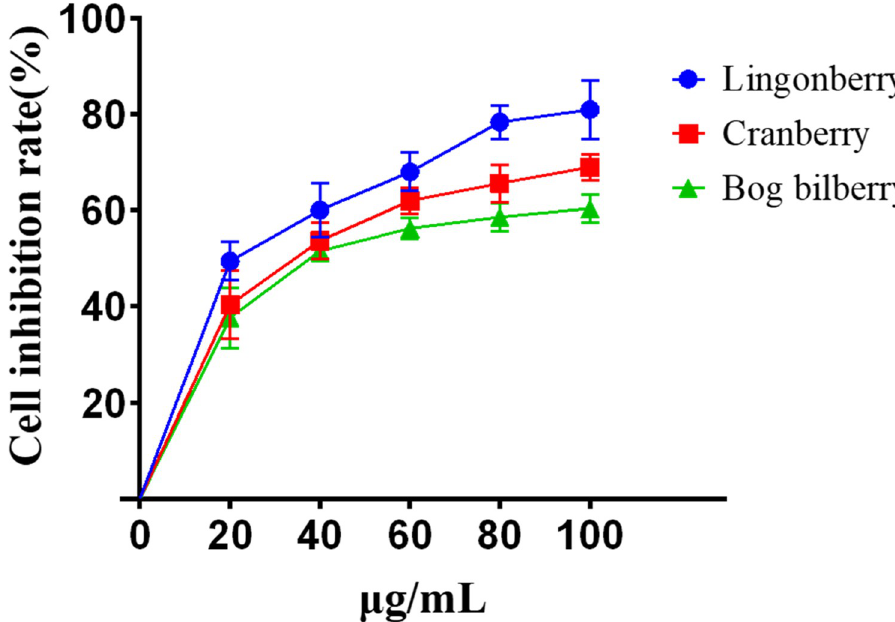
Fig 2. Inhibition rates of various Vaccinium berry extracts on proliferation of HepG2